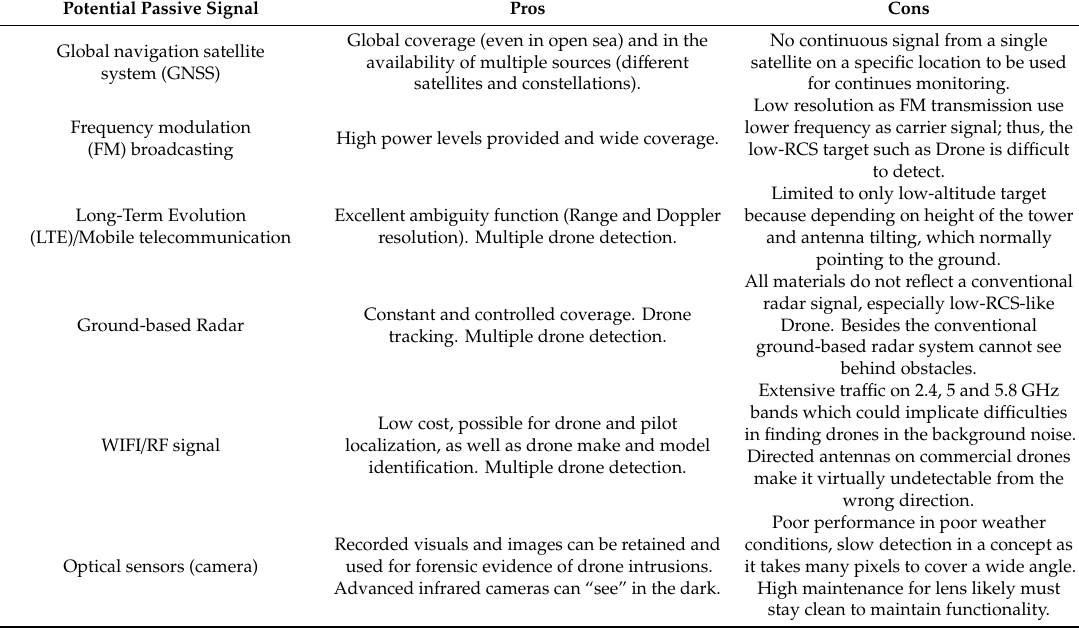
Table 1. Potential signal as passive radar and its fundamental suitability